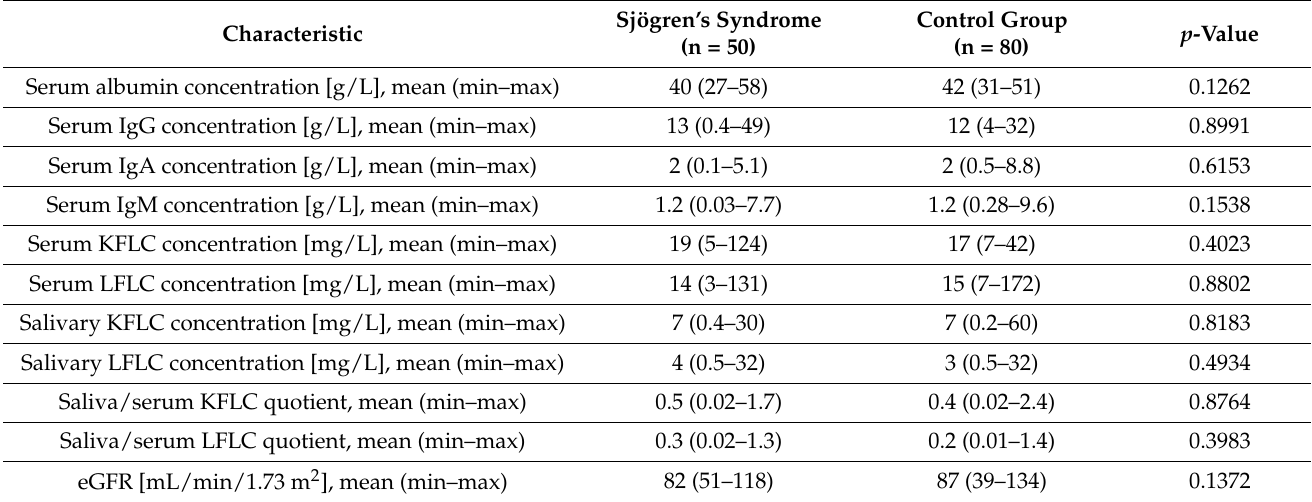
Table 2. Serum and saliva